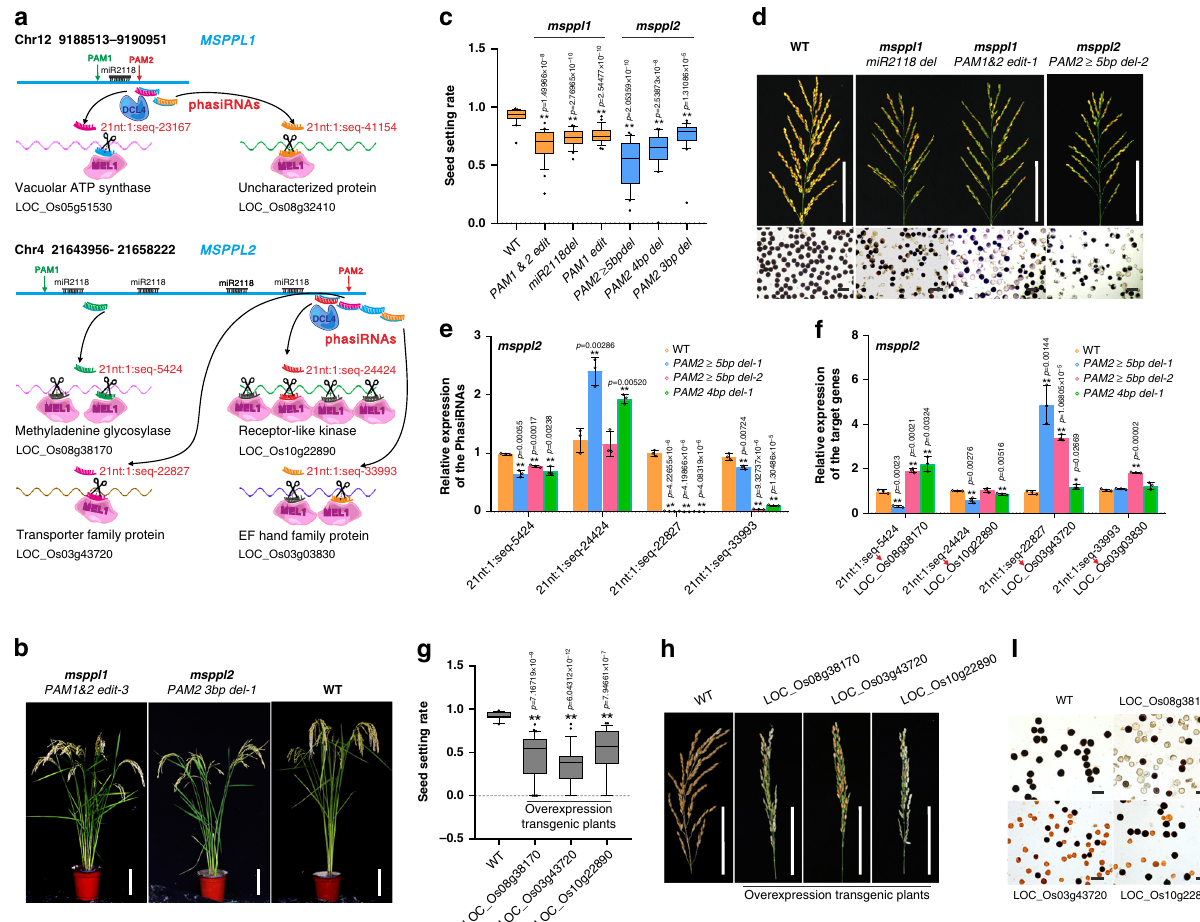
Fig. 5 Functional analysis of phasiRNAs generated from MSPPL1 and MSPPL2 . a Diagram of the two phasiRNA precursor lncRNAs, phasiRNAs and their targets, as well as the knockout mutants generated by CRISPR-Cas9 with PAM sites for Cas9-binding. The red and green arrows indicate the two gRNA target sites. b Gross morphology of wild-type (WT) and msppl1 and msppl2 mutant plants. Scale bars = 15 cm. c Seed-setting rate in different mutants of MSPPL1 and MSPPL2 (the data were generated from PAM1&2 edit -1, -2, -3; PAM1 edit -1, -2, PAM2 ≥ 5 bp del -1, -2, -3; PAM2 4 bp del -1, -2 and PAM2 3 bp del -1, -2 lines, respectively). Box plots indicate median (middle line), 25th, 75th percentile (box) and 10th and 90th percentile (whiskers) as well as outliers (single points). ( n = 20, 23, 22, 26, 20, 20, and 21 plants from left to right, respectively). d Pollen grains and panicles of different mutants of MSPPL1 and MSPPL2 . Scale bars = 10 cm for panicles and 100 µ m for pollen grains. n = 3 independent replicates. e Relative expression of phasiRNAs generated from MSPPL2 . Values are the means ± SD ( n = 3 replicates, normalized against u6 ). f Relative expression of target genes of phasiRNAs generated from MSPPL2 . Values are the means ± SD ( n = 3 replicates, normalized against Actin2 ). g Seed-setting rate of WT and different overexpression transgenic plants. Each target gene was overexpressed independently. Box plots indicate median (middle line), 25th, 75th percentile (box) and 10th and 90th percentile (whiskers) as well as outliers (single points). ( n = 15, 30, 28, and 29 plants from left to right, respectively). h Panicles of WT and different overexpression transgenic plants. Scale bars = 10 cm. i Pollen grains of WT and different overexpression transgenic plants stained with iodine-potassium iodide. Scale bars = 100 µ m. n = 3 independent replicates. Signi fi cant differences were identi fi ed at the 5% (*) and 1% (**) probability levels using two-tailed paired t